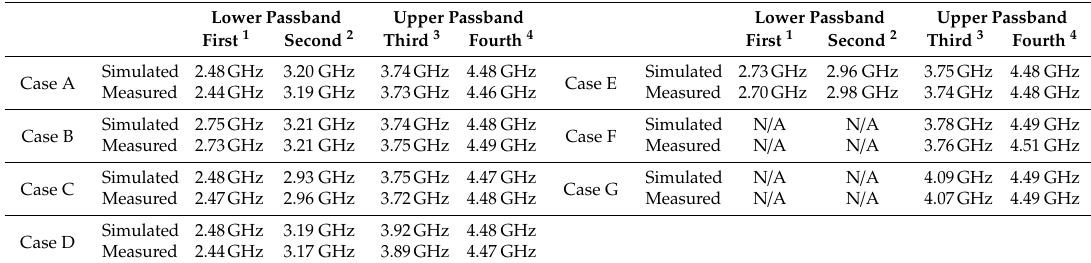
Figure 13. The photograph of the fabricated filter. Table 1. Simulated and measured results under different cases.